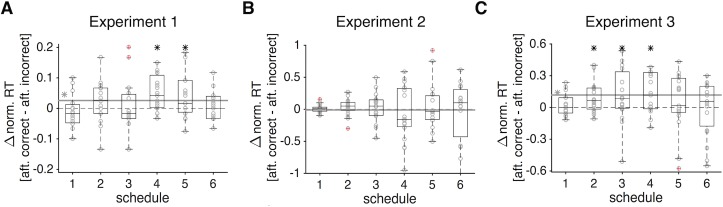
The effects of reward outcome on RT on the subsequent trial.(A) The bar plot shows the difference in median RT after correct and incorrect trials in Experiment 1, and the gray circles show the difference in median RT for individual subjects. The solid gray line shows the average difference over all schedules, and a gray asterisk next to it indicates that this average was significantly different from 0 (two-sided sign test, p < 0.05). A black asterisk indicates that the difference in RT for a given schedule was significantly different from 0 (two-sided sign test, p < 0.05), and outliers are indicated by circles with a red cross. (B, C) The same as in (A) but for Experiments 2 and 3, respectively.